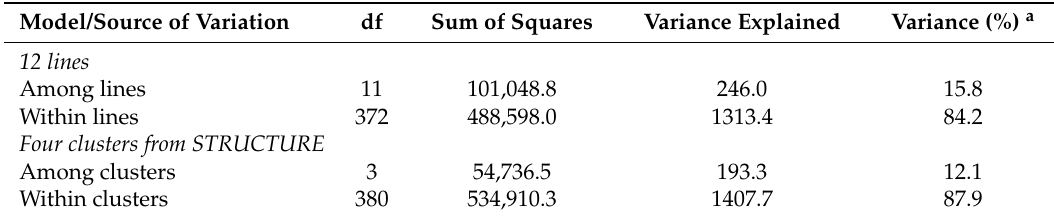
Table 2. Results of the analysis of molecular variance for two models of genetic structure (12 lines and four clusters from the STRUCTURE analysis) based on 45,507 SNP markers.